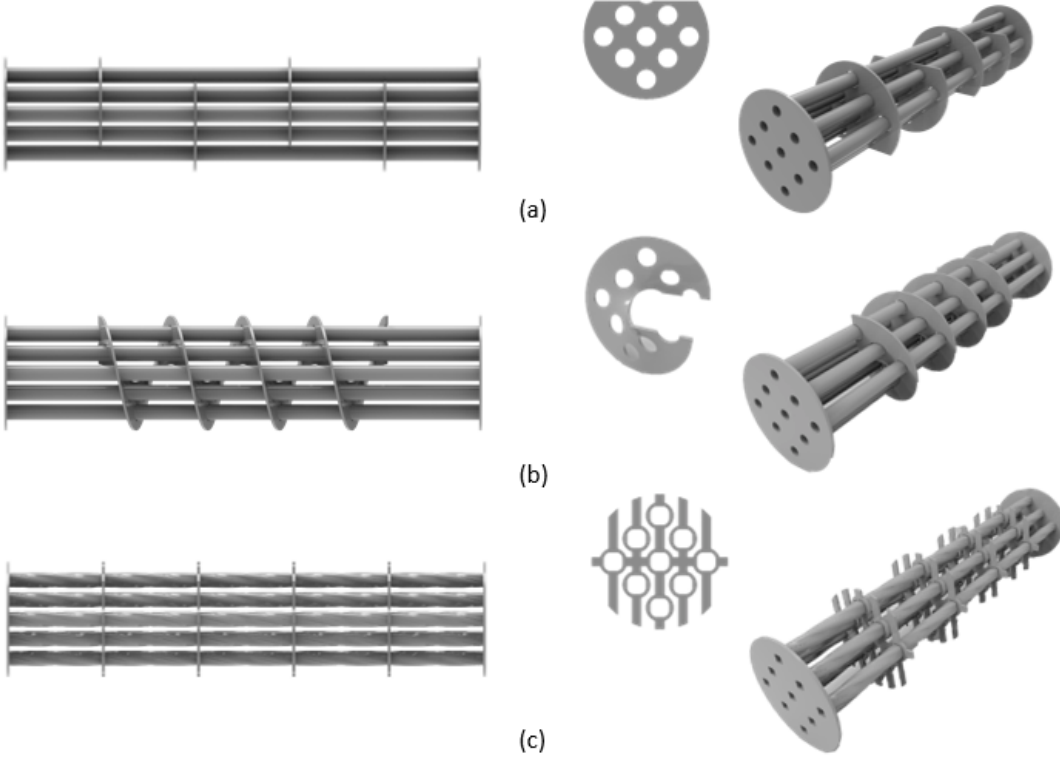
Figure 1. Model of tubes bundles with different baffles types: ( a ) segmental baffles; ( b ) helical baffles; and ( c ) clamping antivibration baffles.